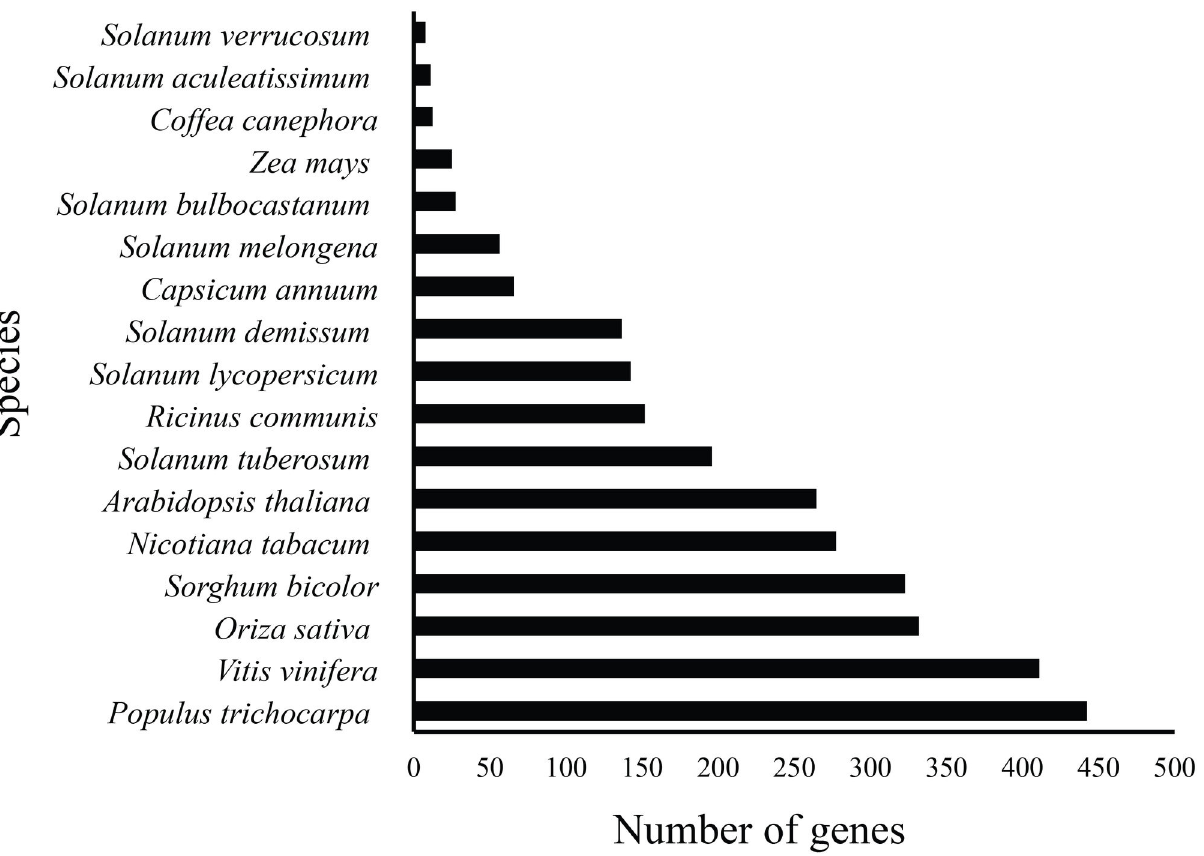
Figure 2. Number of candidate resistance genes related to plant immunity found in model and in non-model plant